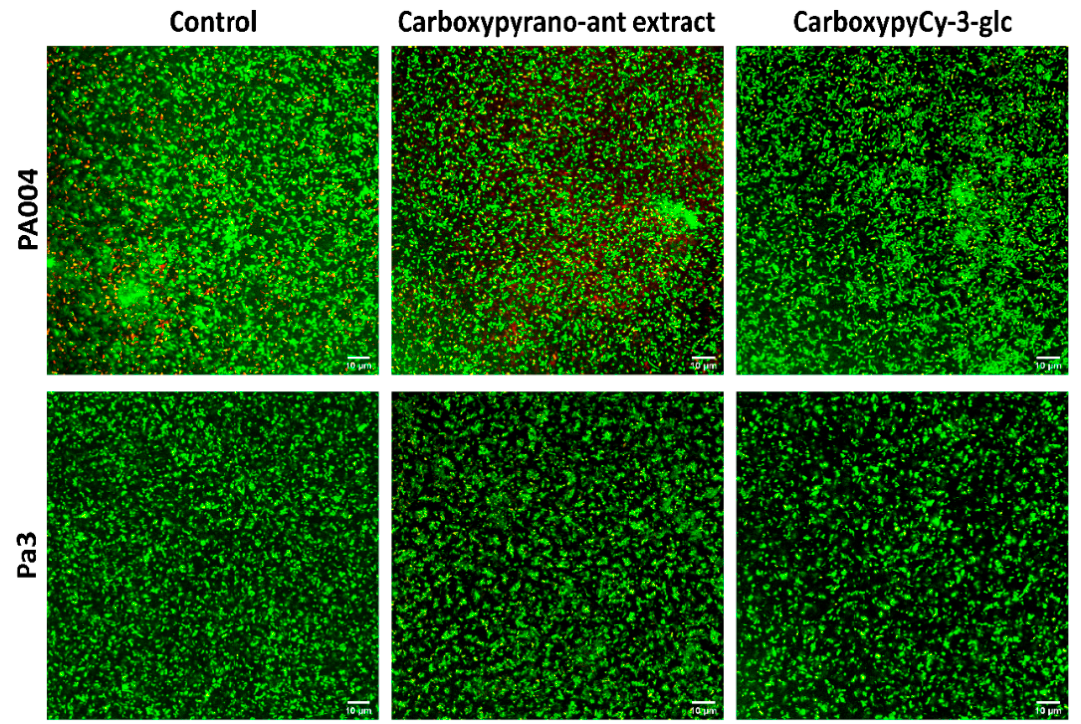
Figure 2. Confocal laser scanning microscopy images, after Live/Dead staining, of PA004 and Pa3 biofilms formed for 24 h in absence (control) and presence of carboxypyrano-ant extract or carboxypyCy-3-glc, at 64 µ g/mL. Scale bar: 10 µ m.